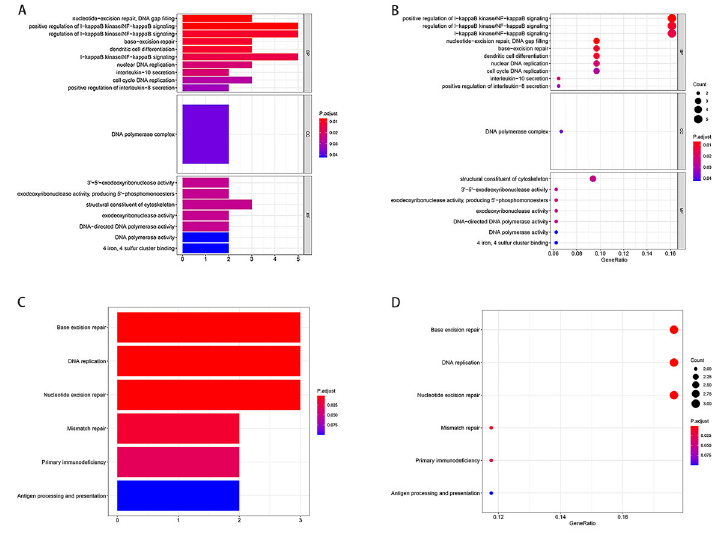
Figure 2. Enrichment analysis of signi fi cantly differential genes (SDGs). A , Bar plot of Gene Ontology (GO) analysis, including the biological process (BP), cellular component (CC), and molecular function (MF) analysis. B , Bubble diagram of GO analysis. Larger bubble and darker color indicate more a signi fi cant enrichment process. C , Bar plot of Kyoto Encyclopedia of Genes and Genomes (KEGG) analysis. D , Bubble diagram of KEGG